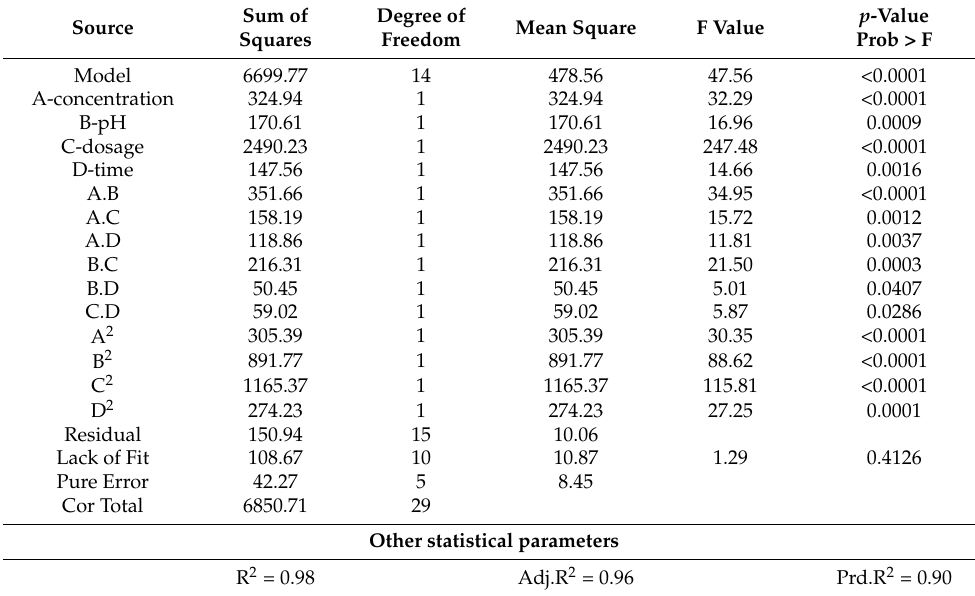
Table 4. ANOVA results of fluoride removal by